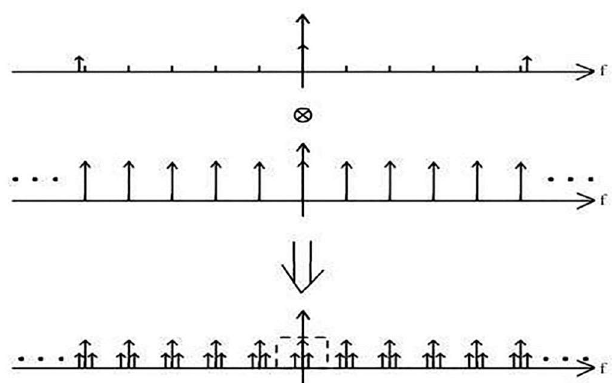
Figure 5. Down-conversion frequency of impulse function.